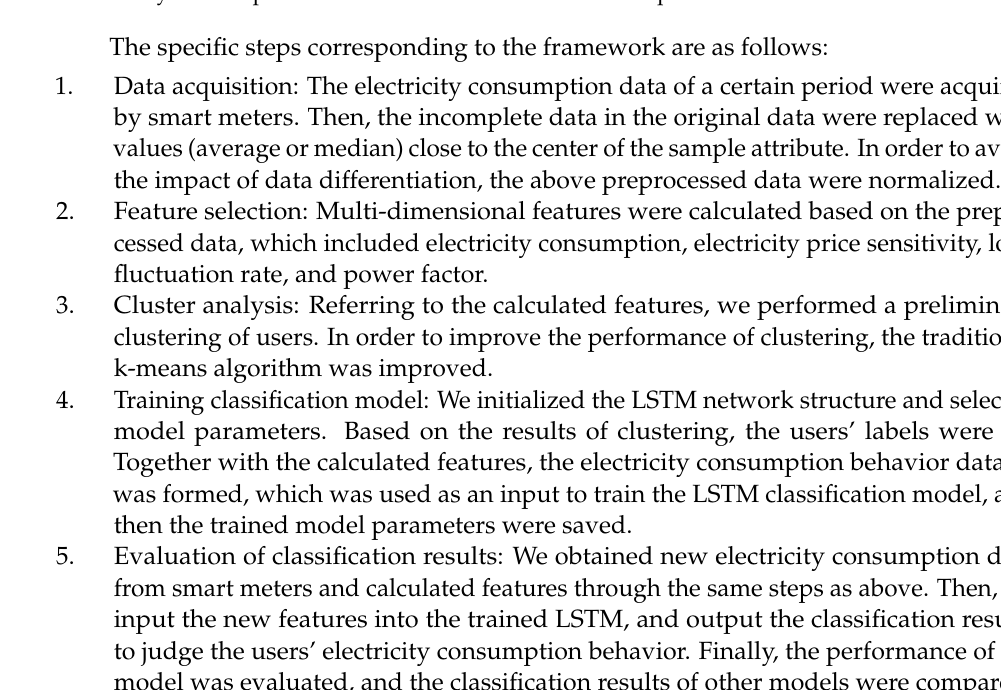
Figure 1. Framework of electricity consumption behavior classification based on improved k-means and LSTM.